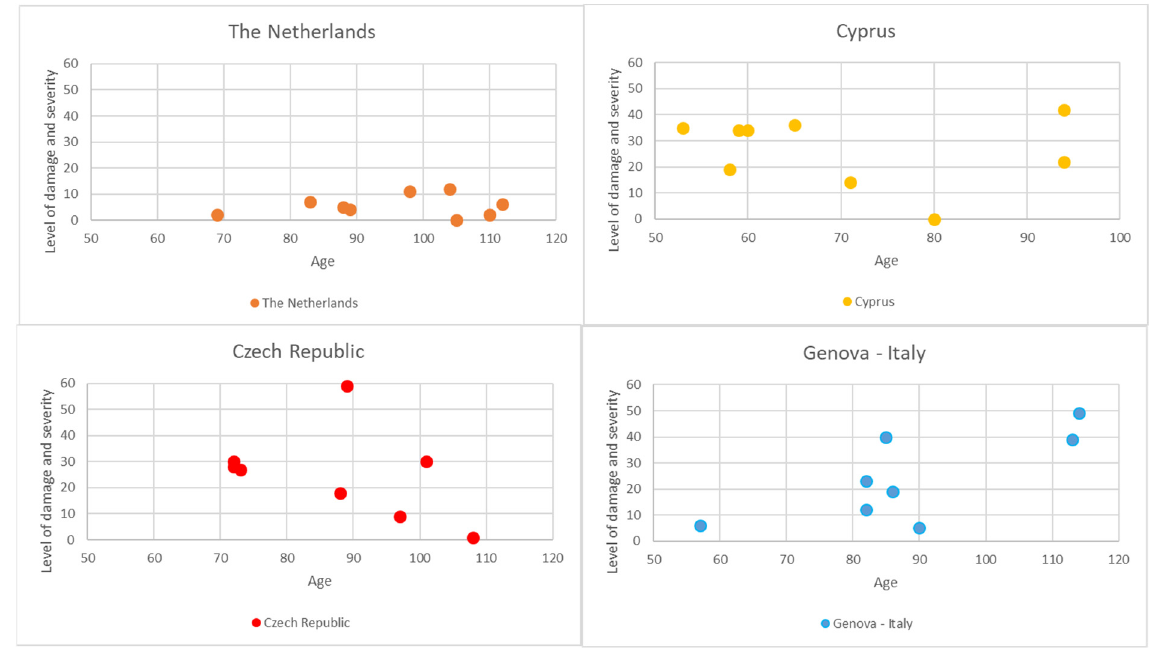
Figure 8. Age (X axis) and Level of damage (Y axis) of the non-restored buildings in each country.